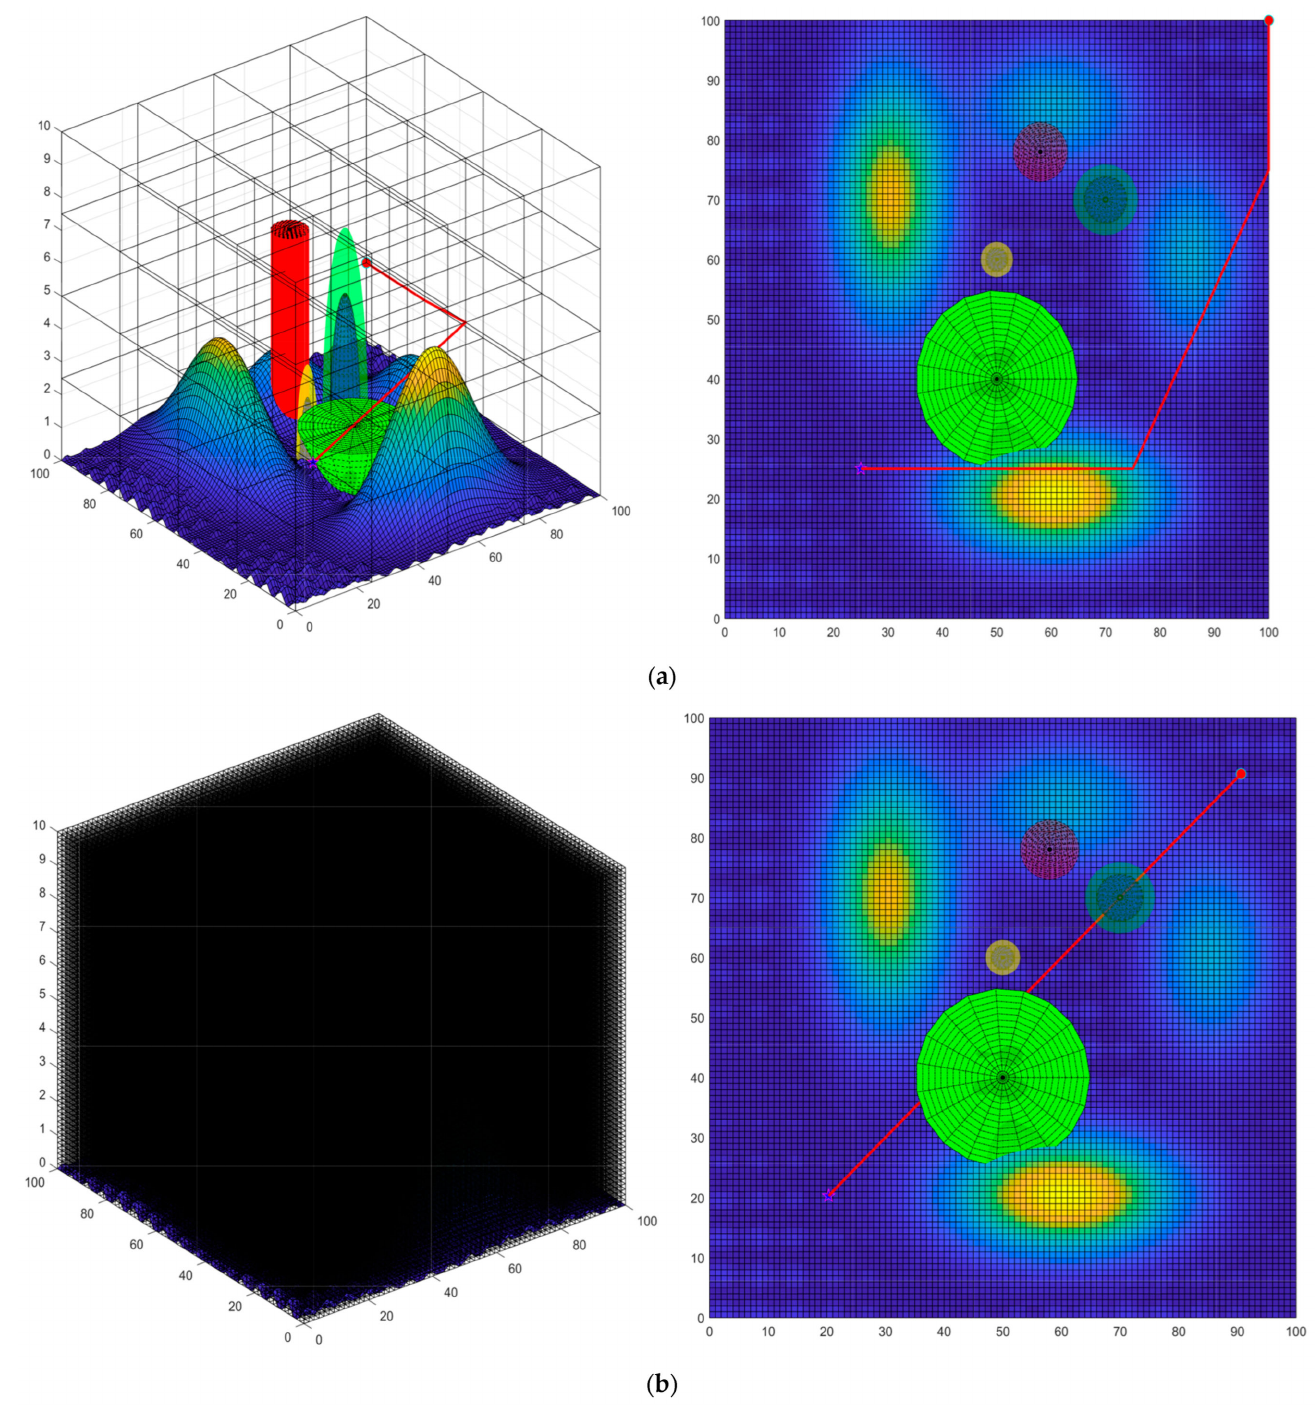
Figure 21. Lazy Theta* route planning at different grid levels. ( a ) Grid level N = 3, and ( b ) N =